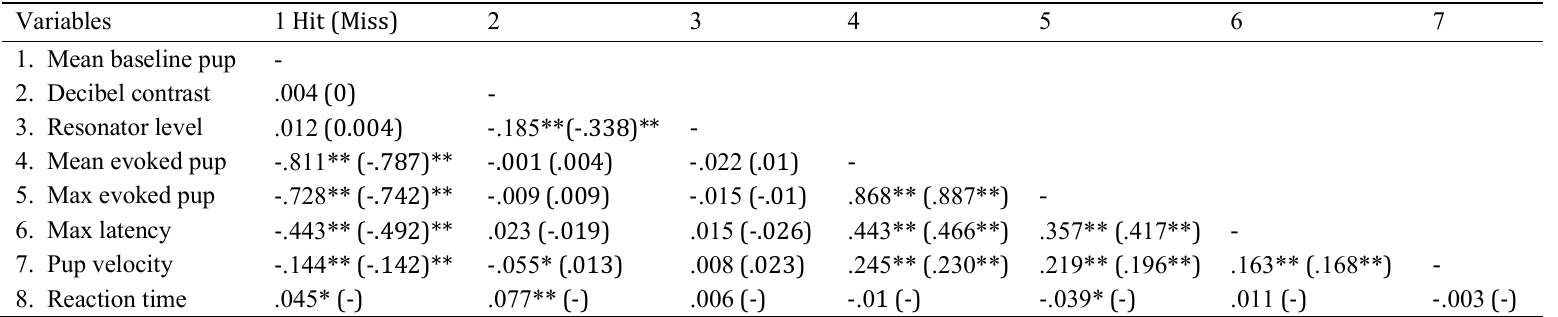
Table 2. Pearson Correlation Coefficients for all predictor and outcome variables on ‘hit’ and ‘miss’ trials. Variables